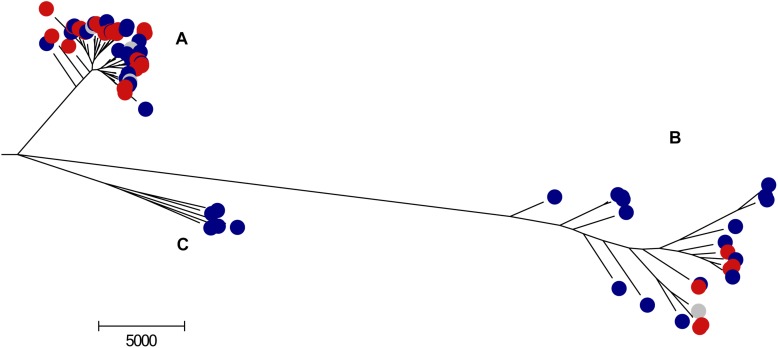
Maximum-likelihood tree of the 82 S. epidermidis strains. The tree was generated by RaxML (Stamatakis et al., 2012) embedded in Gubbins (Croucher et al., 2015), based on the core gene alignment with removal of the recombining regions. In blue are depicted the colonization isolates, in red the infection isolates and in gray are the isolates for which no epidemiological information was available. (A–C) Correspond to S. epidermidis clonal clusters, according to Meric et al. (2015).